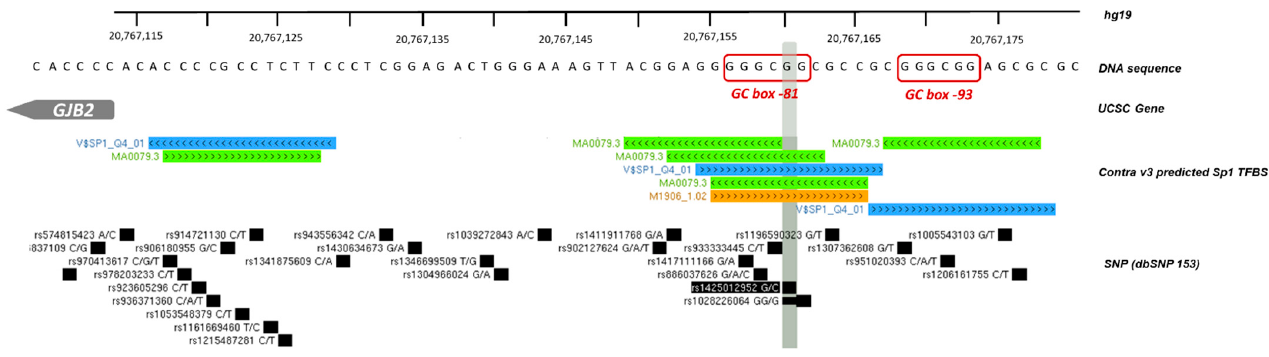
Figure 6. GJB2 promoter and upstream variants detected via WGS analysis. The GJB2 promoter has 2 GC boxes (each located respectively at − 81 and − 93 bp of TSS) that are useful for GJB2 basal transcription. The upstream GJB2 variant is located on GC box -81 and Contrat v3 predicts several Sp1 binding sites at this location (Bioinformatic tool to predict transcription factor binding sites http://bioit2.irc.ugent.be/contra/v3/#/step/1, the 21 May 2021).